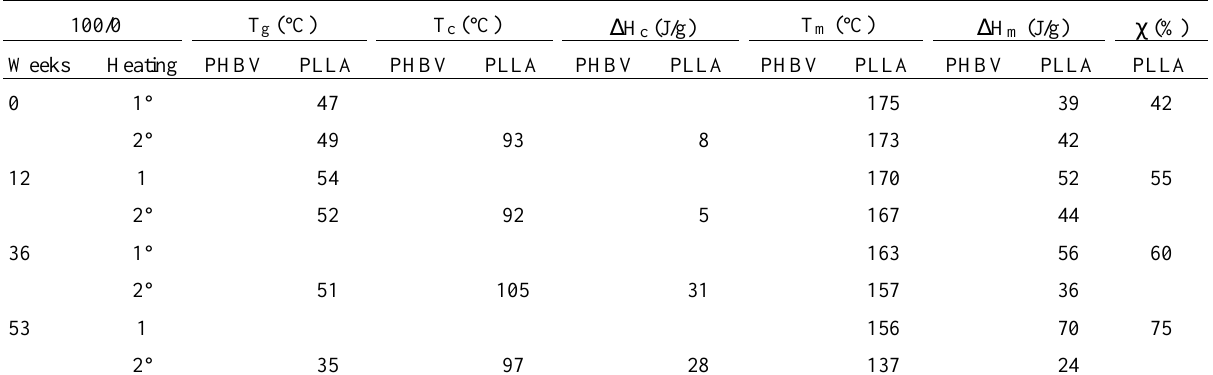
Table 2. Glass Transition (T g ), Crystallization (T c ) and Melting (T m ) Temperatures; Crystallization ( ∆ H c ) and Melting ( ∆ H m ) Enthalpies; Crystallinity Degree ( χ ) obtained by DSC, for films of PLLA/PHBV 100/0 blends in relation to degradation period (weeks).